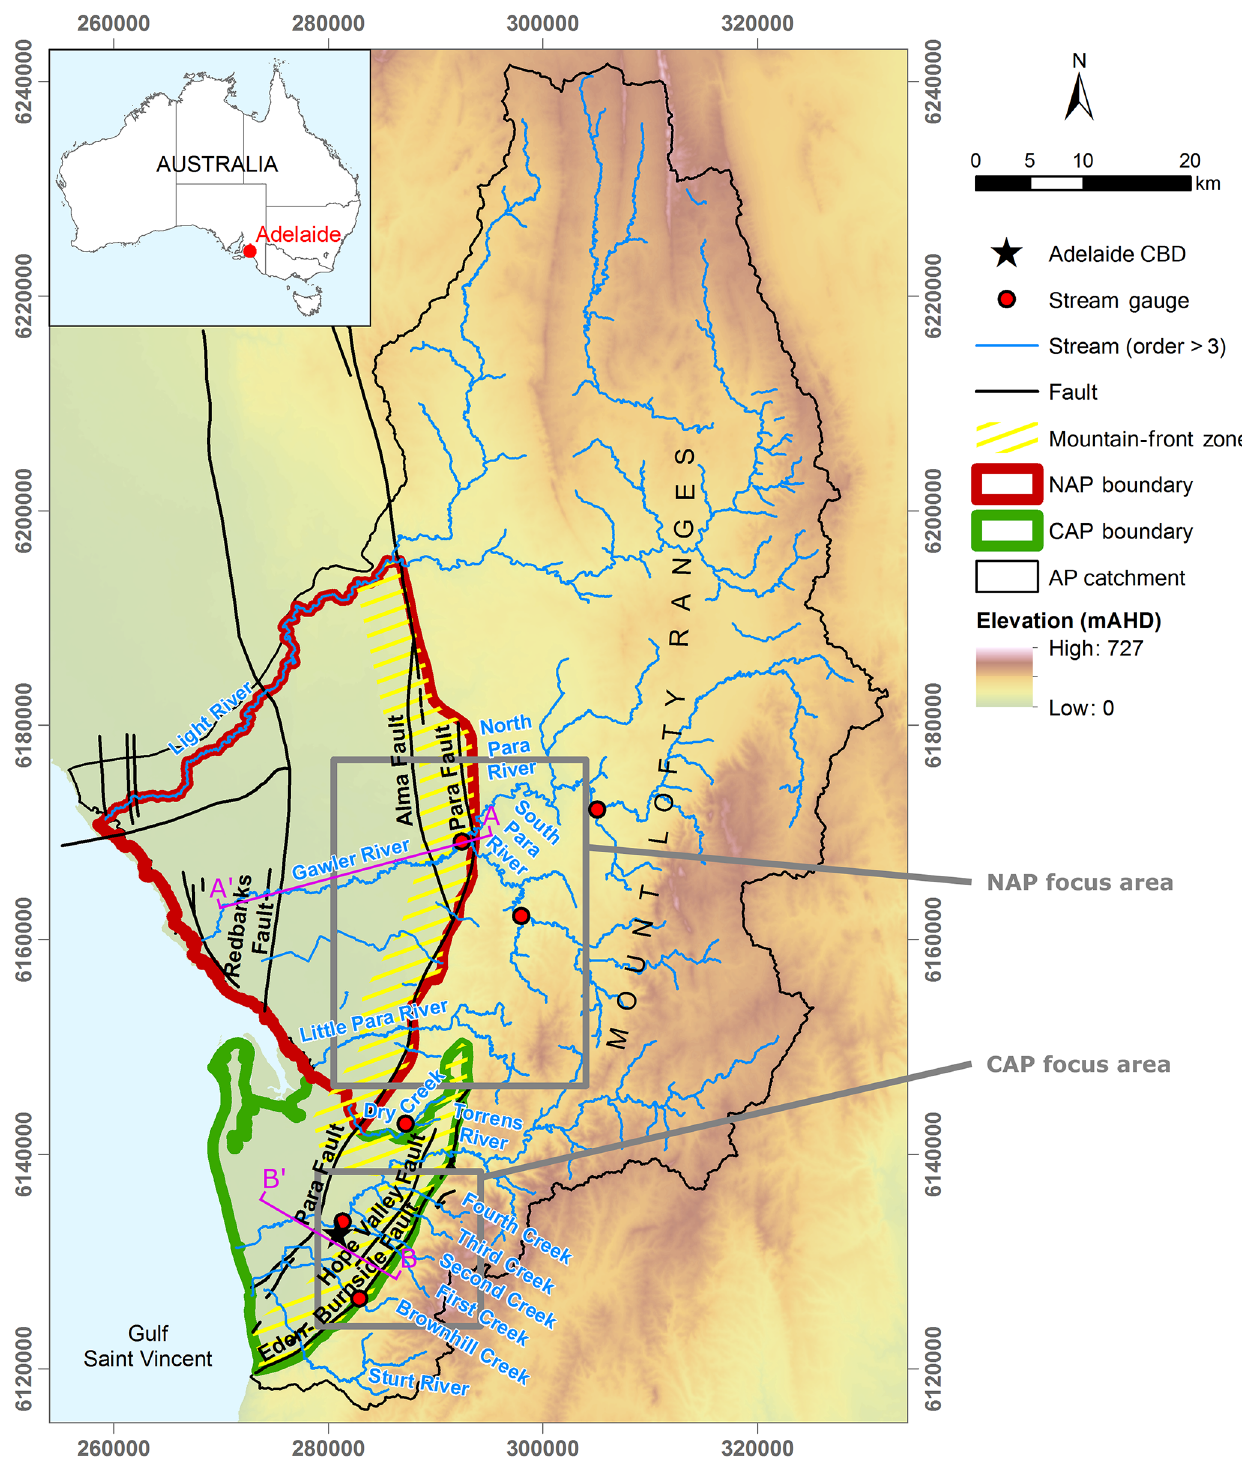
Figure 2. Situation map showing elevation (in metres according to the AHD, i.e. Australian Height Datum) and relevant features of this